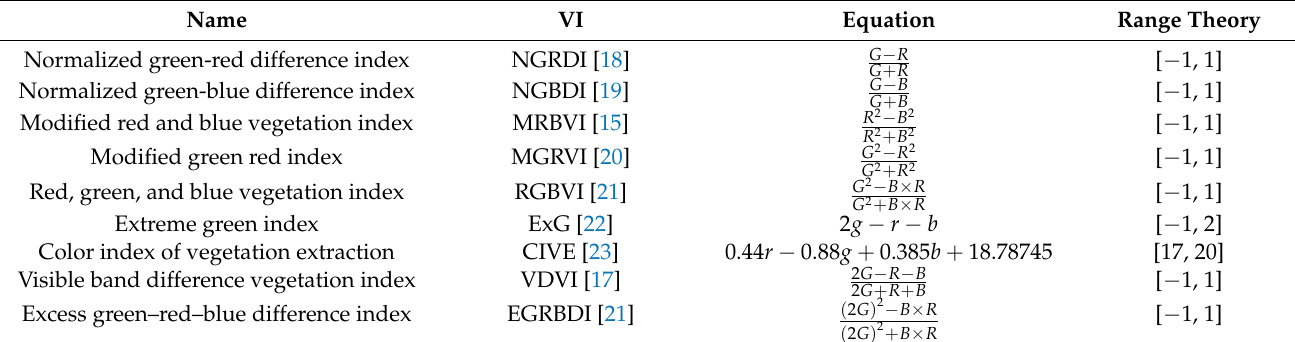
Table 2. Combined VIex in visible